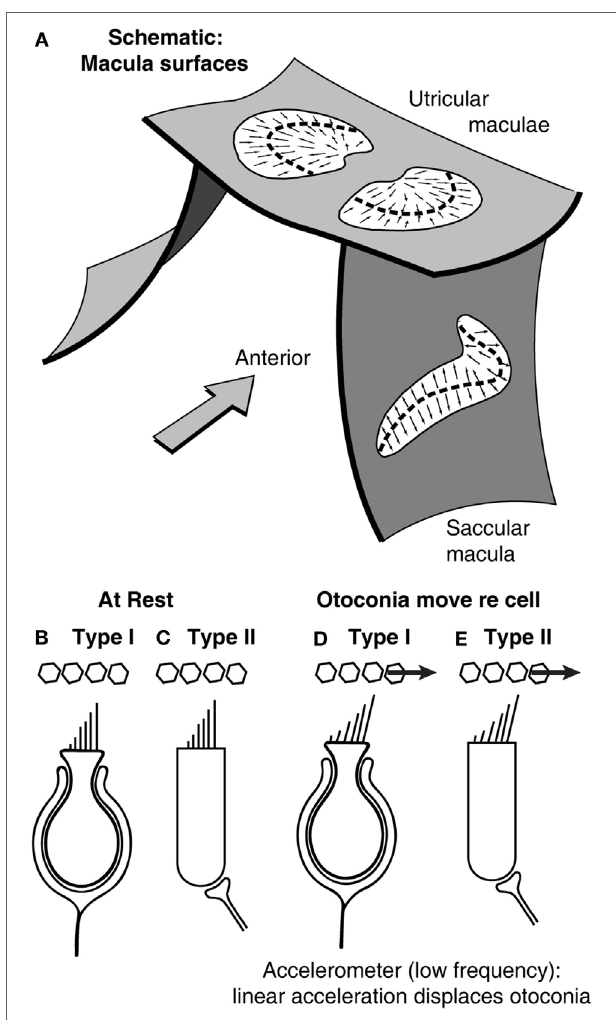
FigURe 2 | (A) Schematic representation of the plates of otolithic receptors (the utricular and saccular maculae). The arrows show the preferred polarization of hair cell receptors across the maculae. The dashed lines are lines of polarity reversal (lpr). The striola refers to a band of receptors on either side of the lpr (27). Schematics of type I (B,D) and type II receptors (C,e) show how linear acceleration acts on otoliths and so deflects the hair bundles of individual